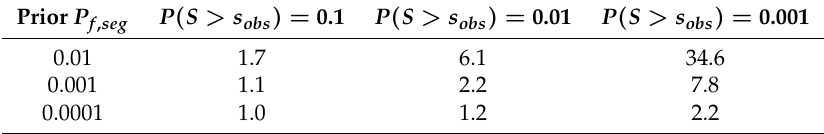
Table 3. Reduction in the segment failure probability, computed as the ratio of prior to posterior segment failure probabilities, after updating with a coupled observation of the load ( s obs ) and survival of the